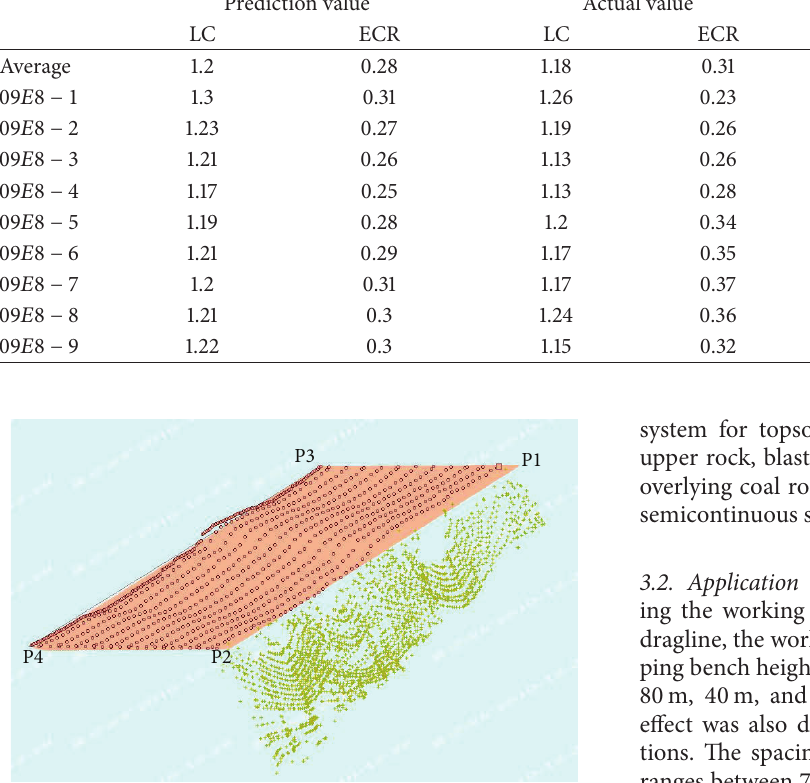
error rates of the LC, ECR, and the muck-pile morphology are less than 10% indicating the accuracy of the predicted